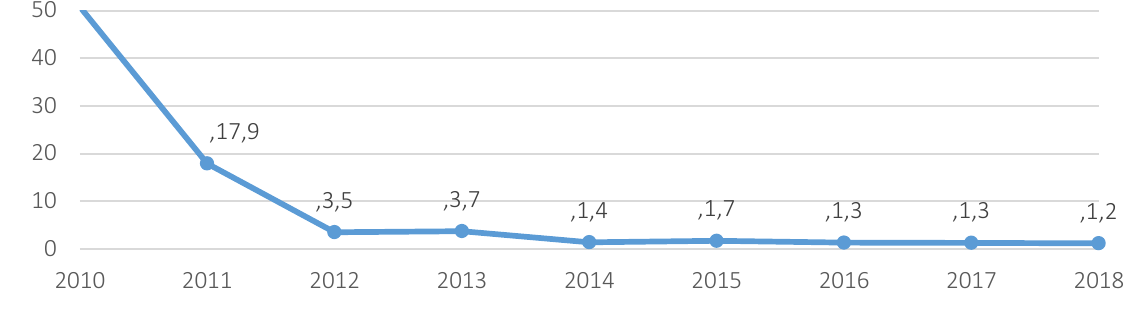
Figure 10. 4th class waste disposal in Odesa region in 2010–2018, percent